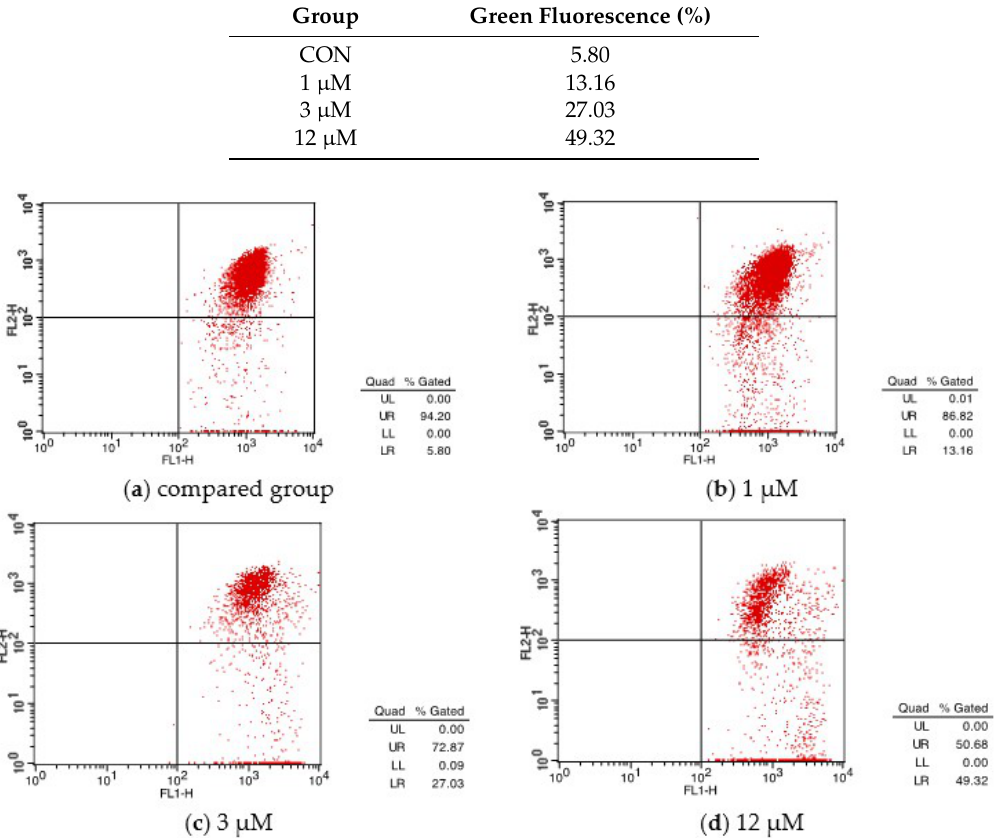
Table 6. Compound 4 effect on HepG2 mitochondrial membrane potential.